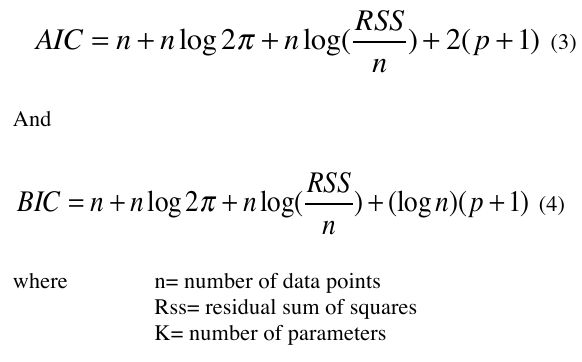
selected. The first run stopped using 24 parameters with an r- squared of 0.71, AIC of 164.26 and BIC of 210.15. Upon plotting the parameters not used in each combination, four (4) significant parameters appeared not to be in used.